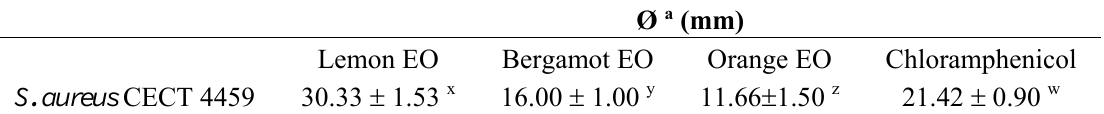
Table 2. Antibacterial activity of the EOs from citrus, using a paper disc-diffusion method, expressed by diameter (mm) of inhibition zone (including the disc diameter, 6 mm).